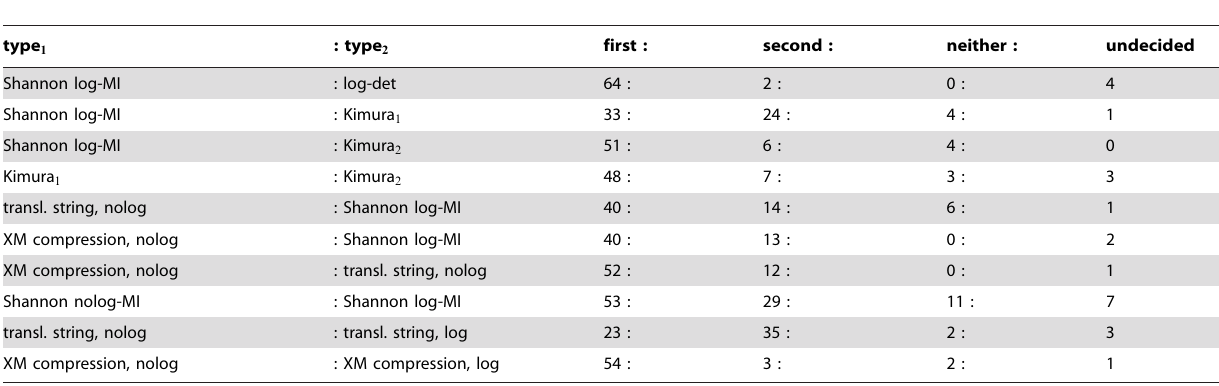
Table 2. Pairwise comparisons between different distance measures for complete mammalian